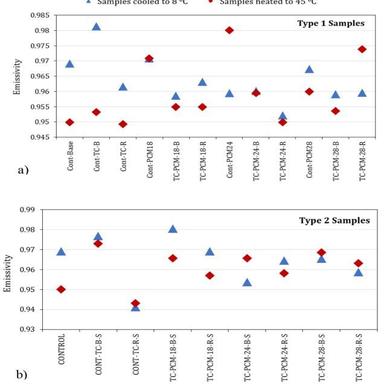
Emissivity of the samples in the heating and the cooling cycle.